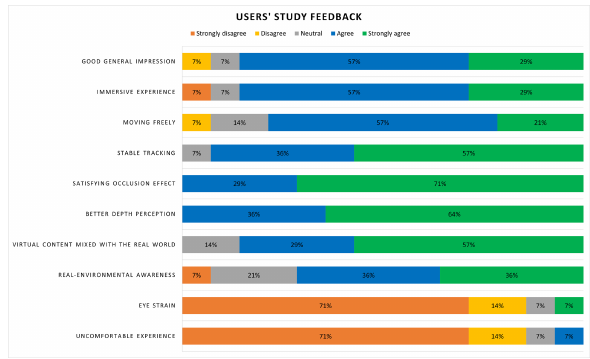
Figure 10. Summary of the users’ study